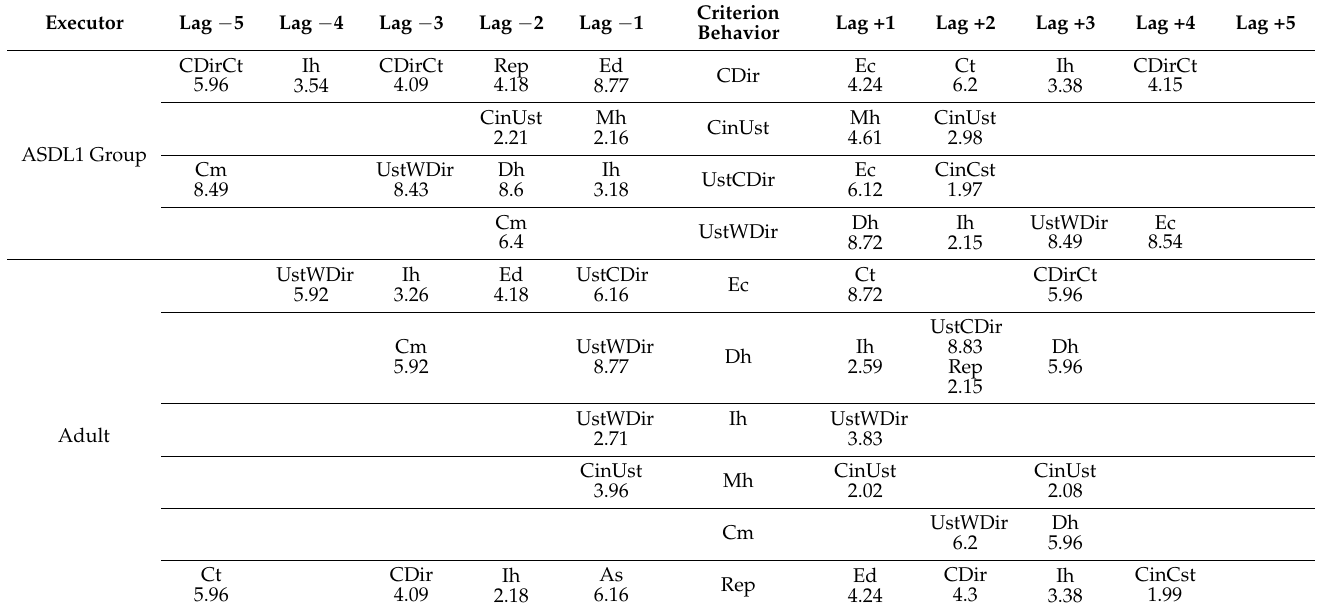
Table 2. Behavioral patterns obtained in the ASDL1 Group at the beginning of the intervention. Central column = It contains the criteria behaviors. Remaining cells = They contain the conditional behaviors. Numbers = Significant adjusted residuals values. Green codes = The most relevant behaviors indicating children progress in interference control. Red codes = The most relevant wrong interference control behaviors of the children. Blue codes = The most relevant adult scaffolding